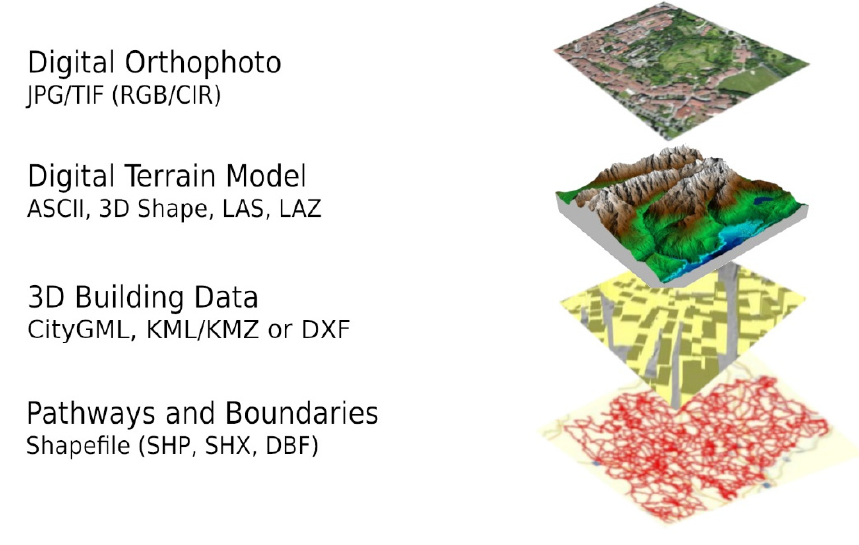
Figure 2. O ffi cial survey data. Types and data Figure 2. Official survey data. Types and data formats.